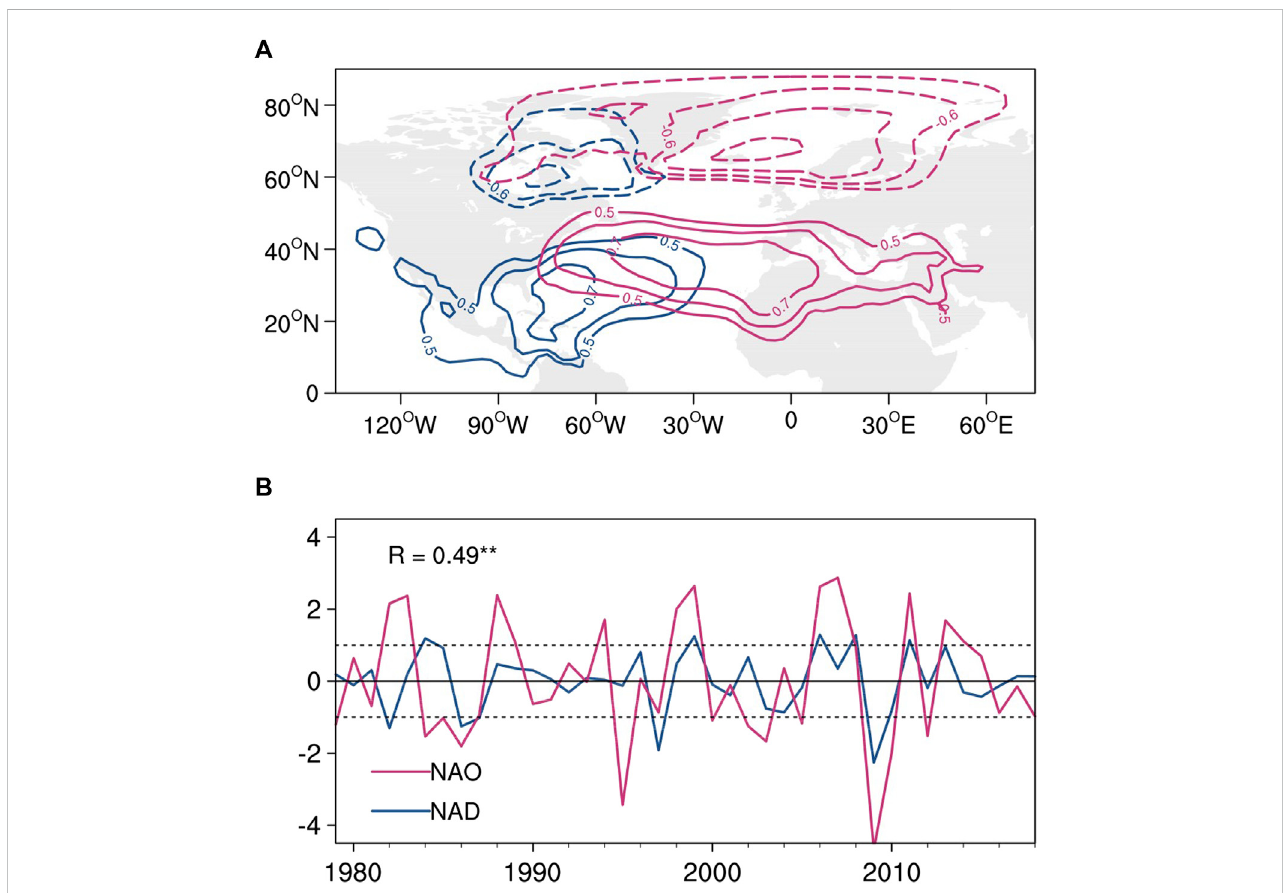
FIGURE 1 (A) Maps of correlation between the DJFM-averaged SLP anomalies and the simultaneous NADI (blue lines) and NAOI (red lines). The contour interval is 0.1. Only correlations greater than 0.5 are shown. (B) the interannual time series of the DJFM-averaged NADI (blue line) and NAOI (red line). The horizontal dashed lines indicate ±1 standard deviation. The correlation coef fi cient (R) between the NADI and NAOI is shown in the top left corner.